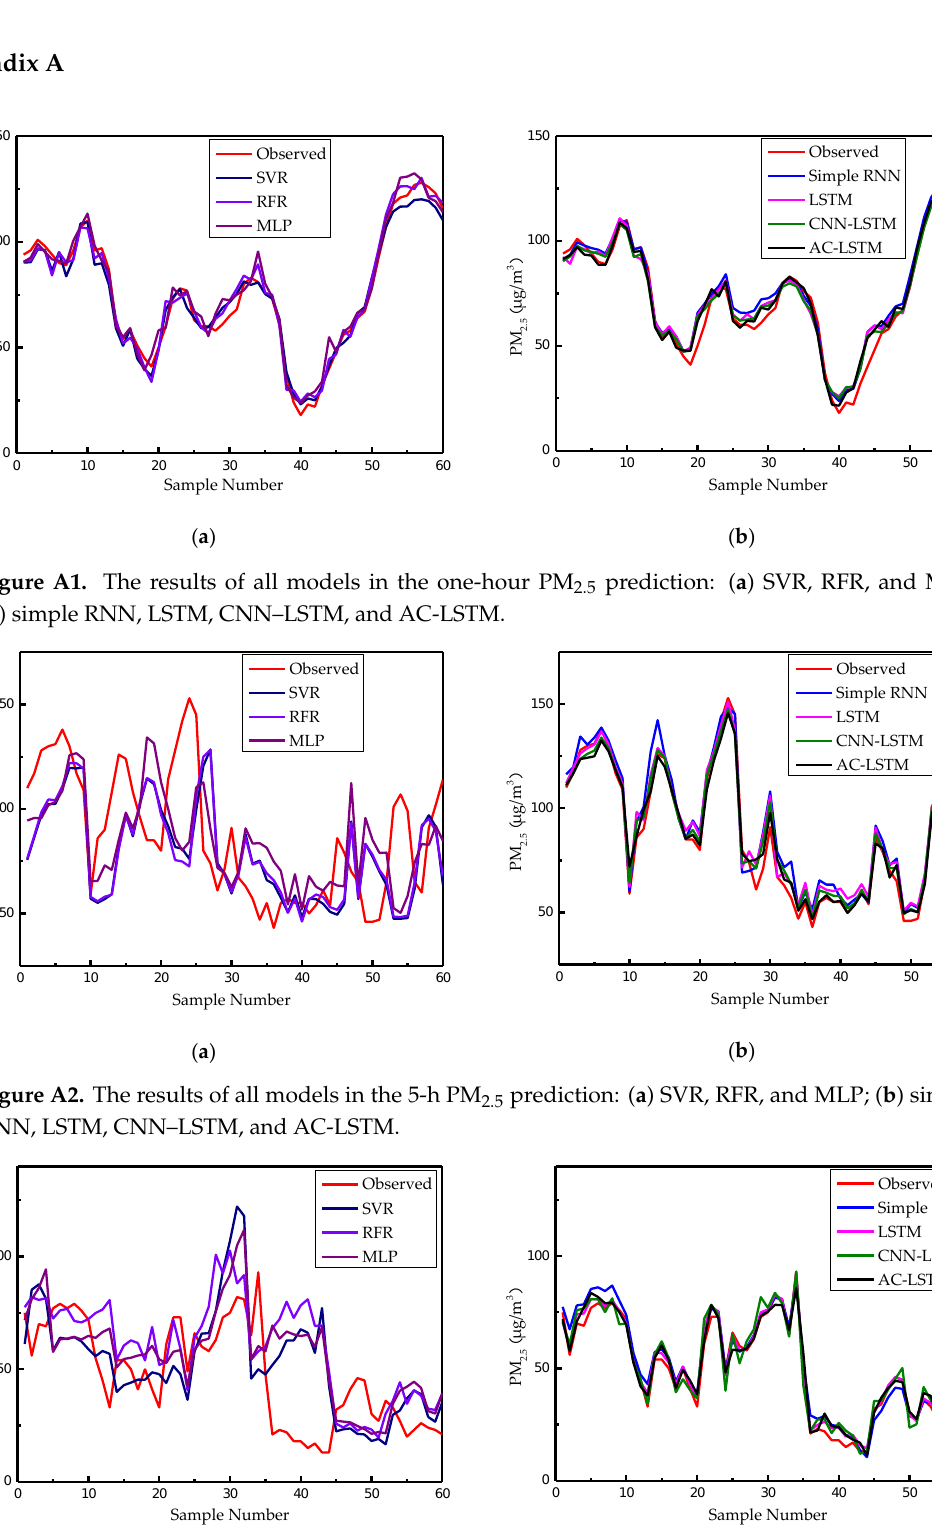
( b ) Figure A4. The results of all models in the 19-h PM 2.5 prediction: ( a ) SVR, RFR, and MLP; ( b ) simple RNN, LSTM, CNN–LSTM, and AC-LSTM. 0